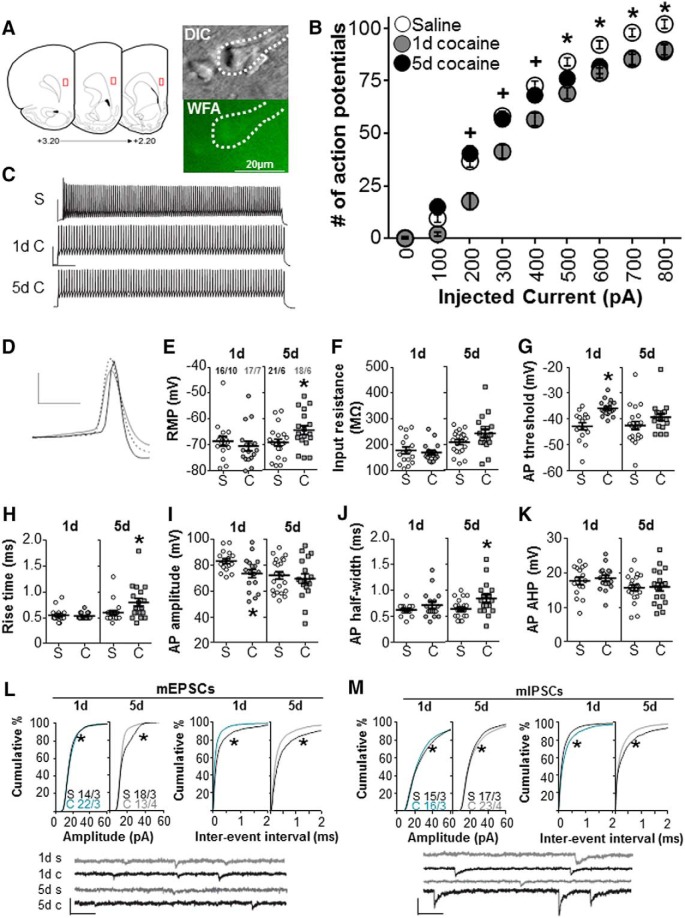
Intrinsic and synaptic properties of FSIs surrounded by PNNs exposed to cocaine in the prelimbic PFC. Data are the mean ± SEM. Fast-spiking interneuron properties 2 h following 1 or 5 d of saline or cocaine exposure. A, Recording locations in layer V of the prelimbic PFC. B, Action potentials recorded from FSIs surrounded by WFA. *p < 0.0001 comparing between saline and both cocaine groups; +p < 0.0001 comparing between saline and 1 d of cocaine exposure. C, Trace examples of recorded FSIs at 800 pA. Calibration: 50 ms, 50 mV. D, Trace example of first elicited action potential (AP). Dashed = saline exposure; gray = 1 d of cocaine exposure; black = 5 d of cocaine exposure. Calibration: 20 mV, 500 μs. E–K, Intrinsic properties were as follows: resting membrane potential (E), input resistance (F), AP threshold (G), rise time (H), AP amplitude (I), AP half-width (J), and AP afterhyperpolarization potential (K), comparing acute and repeated cocaine (C) to acute and repeated saline controls (S), respectively. L, Cumulative frequency plots of mEPSC amplitudes and interevent intervals. Trace examples are shown below. Calibration: 50 pA, 500 μs. M, Cumulative frequency plots of mIPSC amplitudes and interevent intervals. Trace examples are shown below. The number of cells/number of rats used is shown (E, L, M).